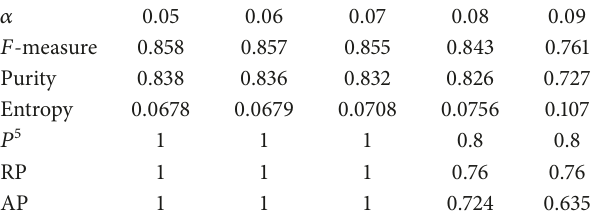
Table 8: The results of evaluation metrics on different 𝛼 ( 𝛽 = 0 ).